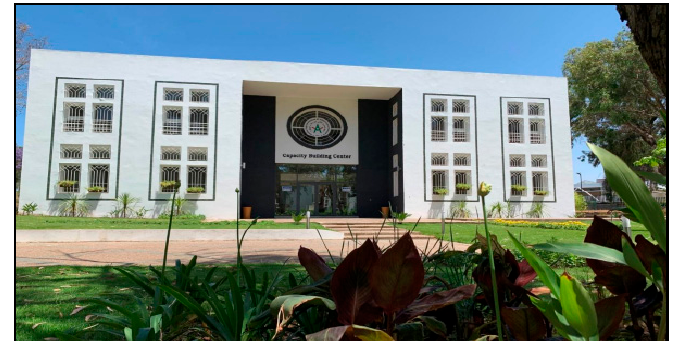
Figure 3. The case study building. Indoor point cloud